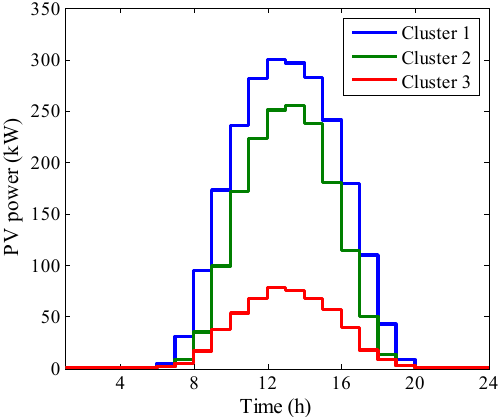
Figure 4. The cluster center curves of three PV clusters obtained by the GMM method.